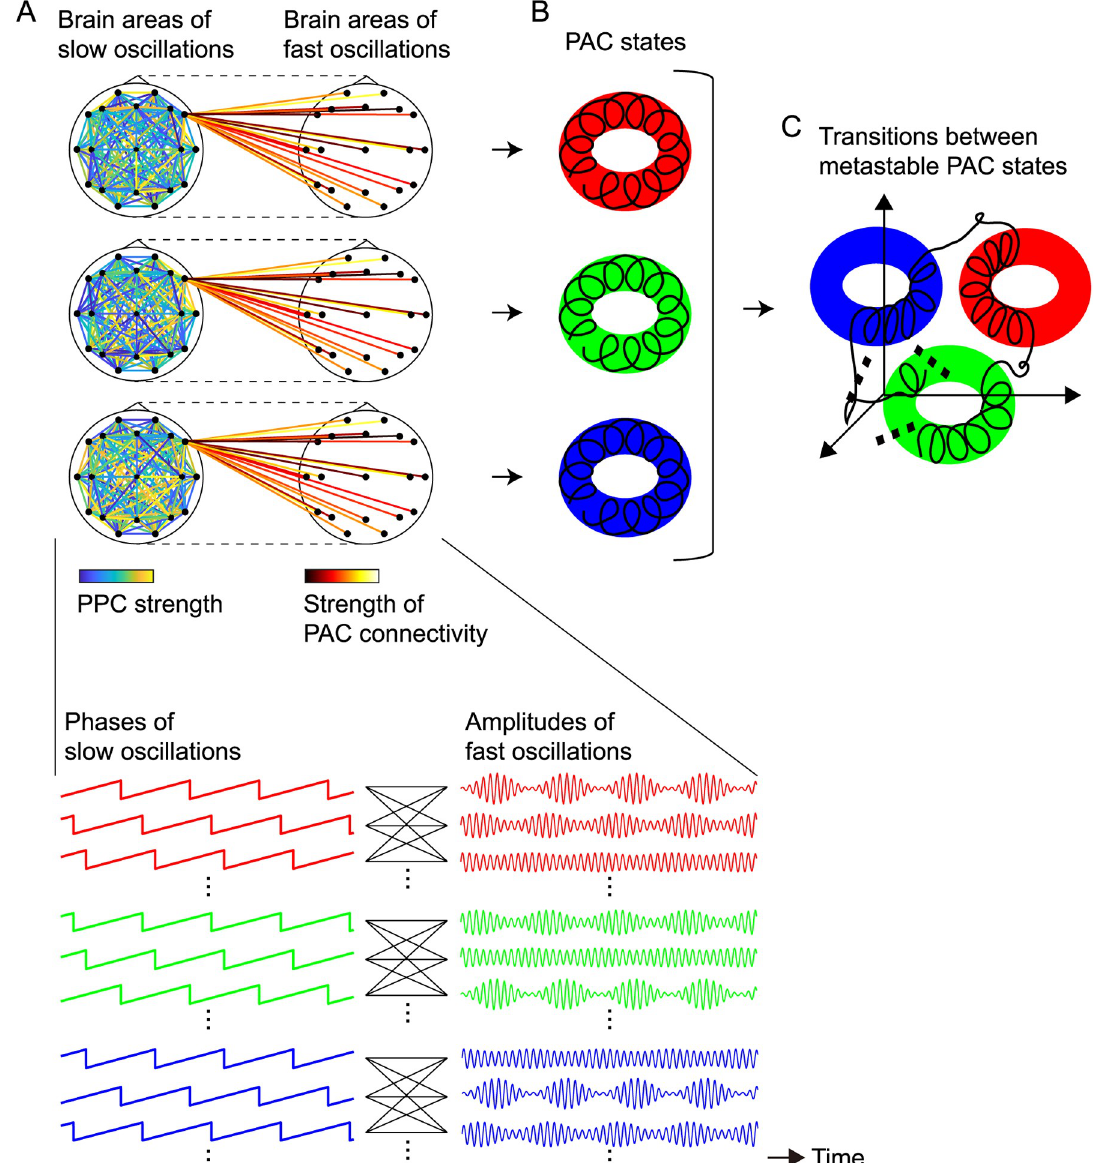
Fig 1. The dynamic PPC-PAC hypothesis. (A) A repertoire of synchronous slow oscillations that interact via the PPC and interact with fast oscillations via the PAC. (B) The resulting PAC states. (C) Transitions between the metastable PAC states. The dynamic PPC-PAC hypothesis states that for the resting brain, dynamic changes in PPC strengths (transitions between synchronous states) can cause dynamic and large-scale changes in PAC strengths because of PPC-PAC connectivity (A), and thereby yield transitions between oscillatory states with multiple peak frequencies (B and C). The oscillations of each state can realize the transition to another state by spontaneous fluctuations in the brain; in other words, the underlying states can show